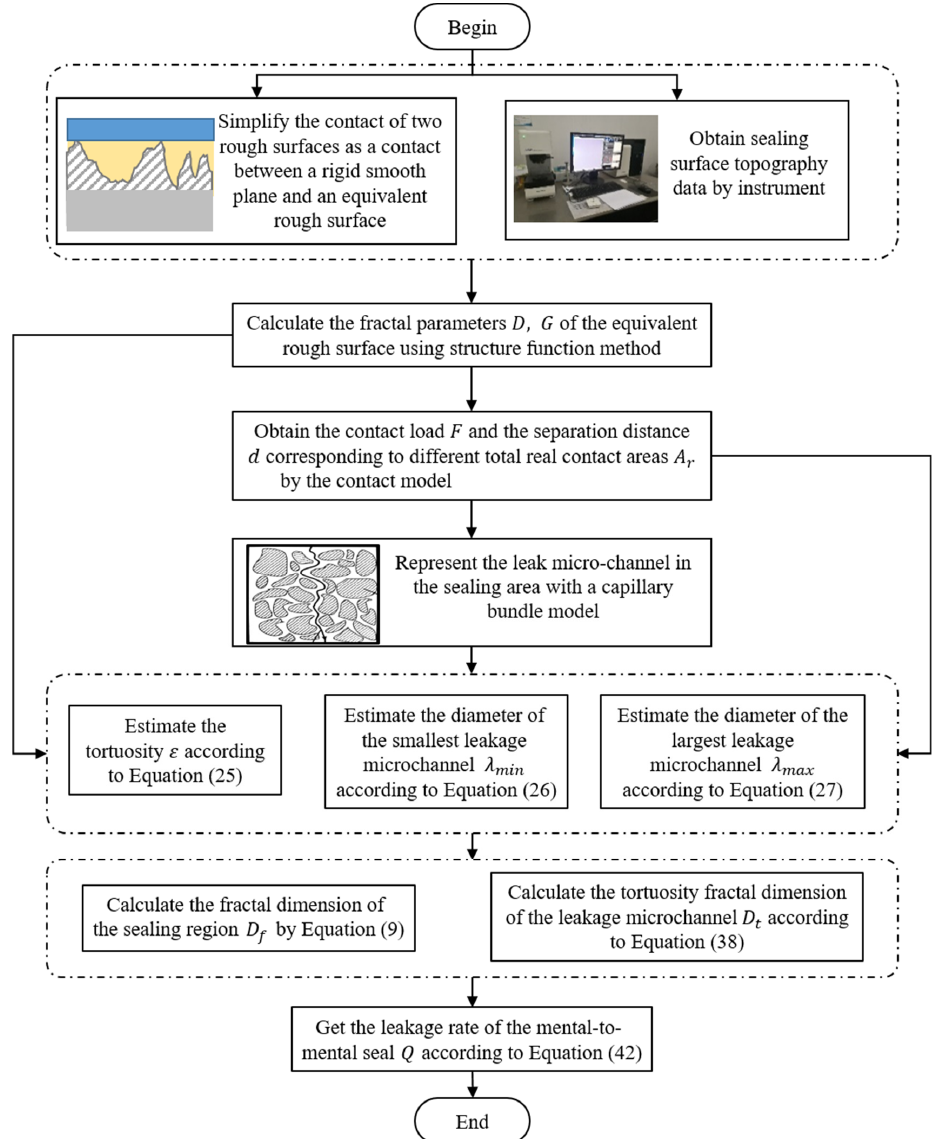
Figure 9. Flowchart for the calculation of the flow rate of the porous medium [43].